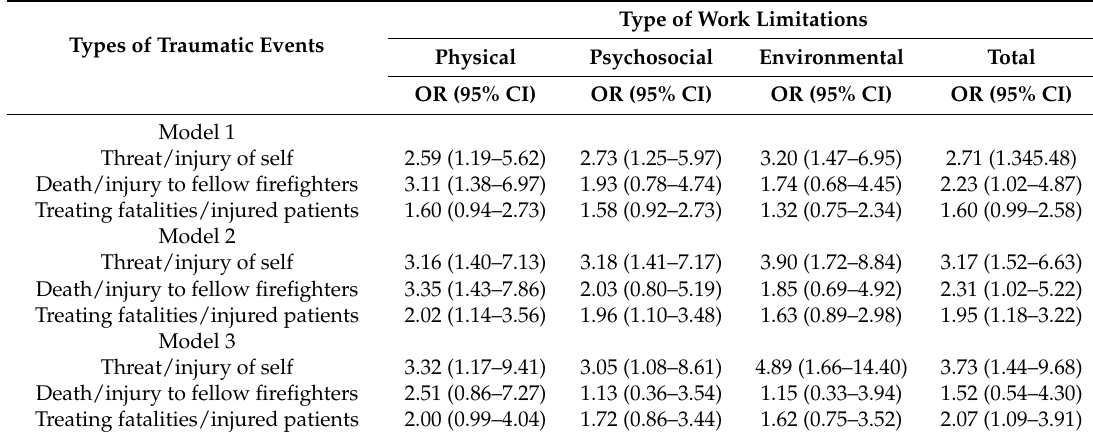
Table 4. Multivariable logistic regression odds ratios (OR): Relationship between work limitations and work-related traumatic